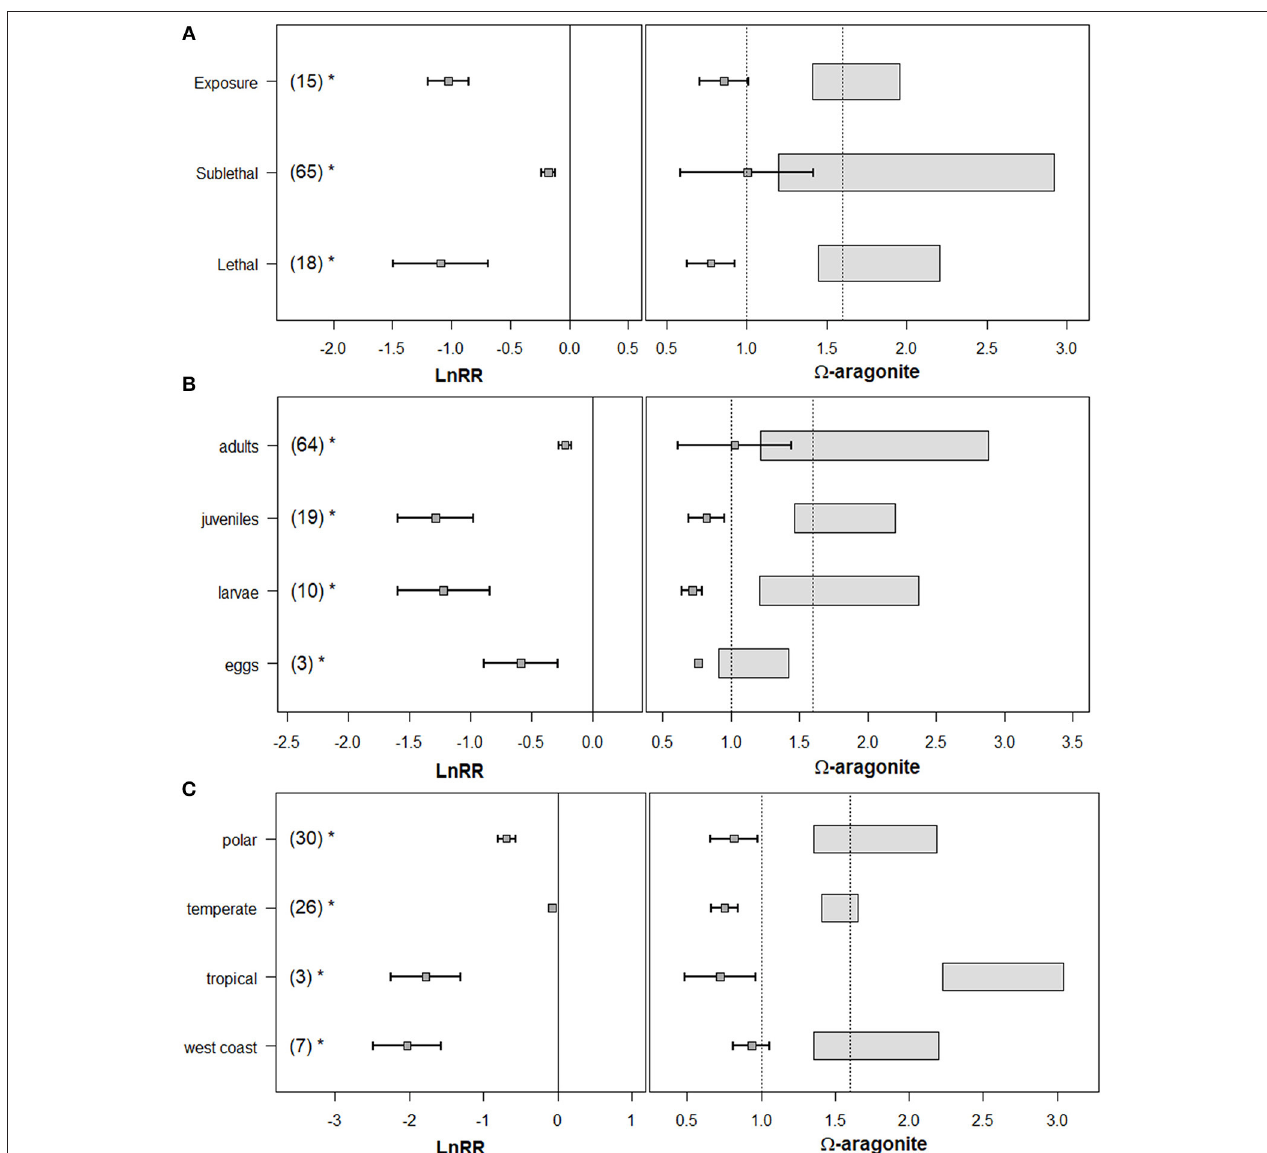
FIGURE 4 | The variability in LnRR responses across (A) , exposure response, sublethal, and lethal responses, (B) , across various life-stages, and (C) , with specific regionality. LnRR (Logarithmic response ratios) indicate the magnitude of the response, with the asterisks indicating its significance (negative associated with negative LnRR values; and positive associated with positive LnRR values). LnRR value crossing zero line indicates the insignificance of the